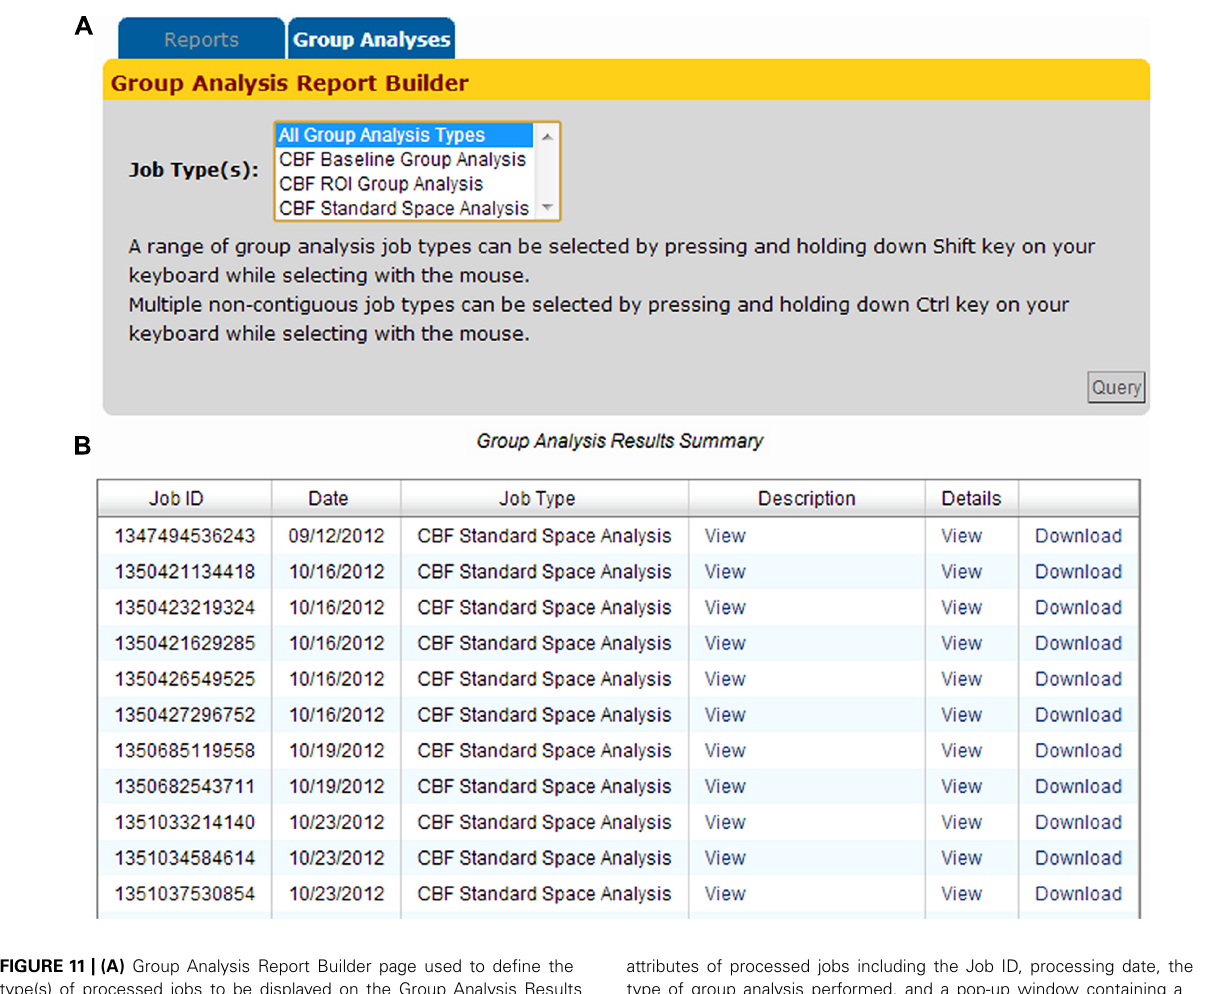
FIGURE 11 | (A) Group Analysis Report Builder page used to define the type(s) of processed jobs to be displayed on the Group Analysis Results Summary table. (B) The table provides a quick access to the relevant